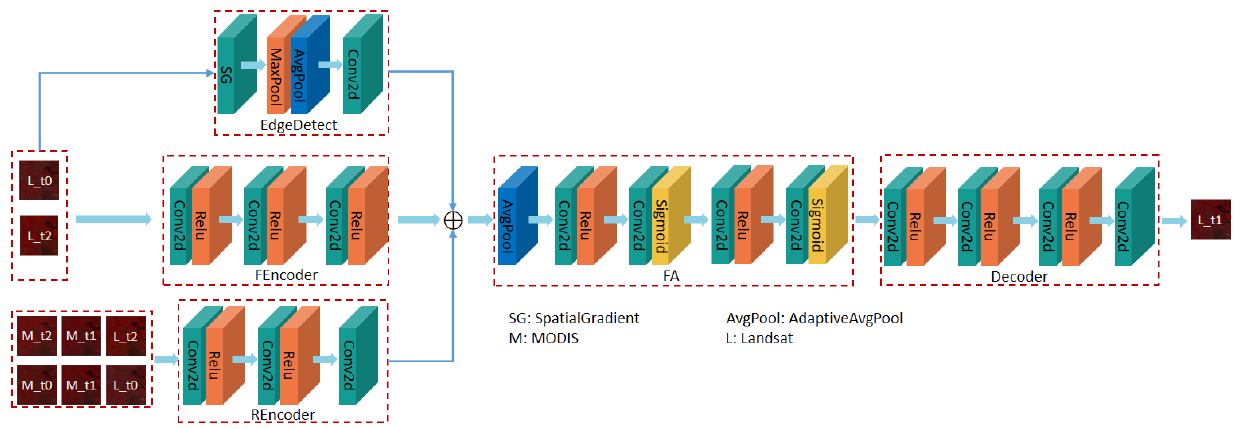
Figure 1. Architecture of the deep convolutional spatiotemporal fusion network (STF-EGFA) model.